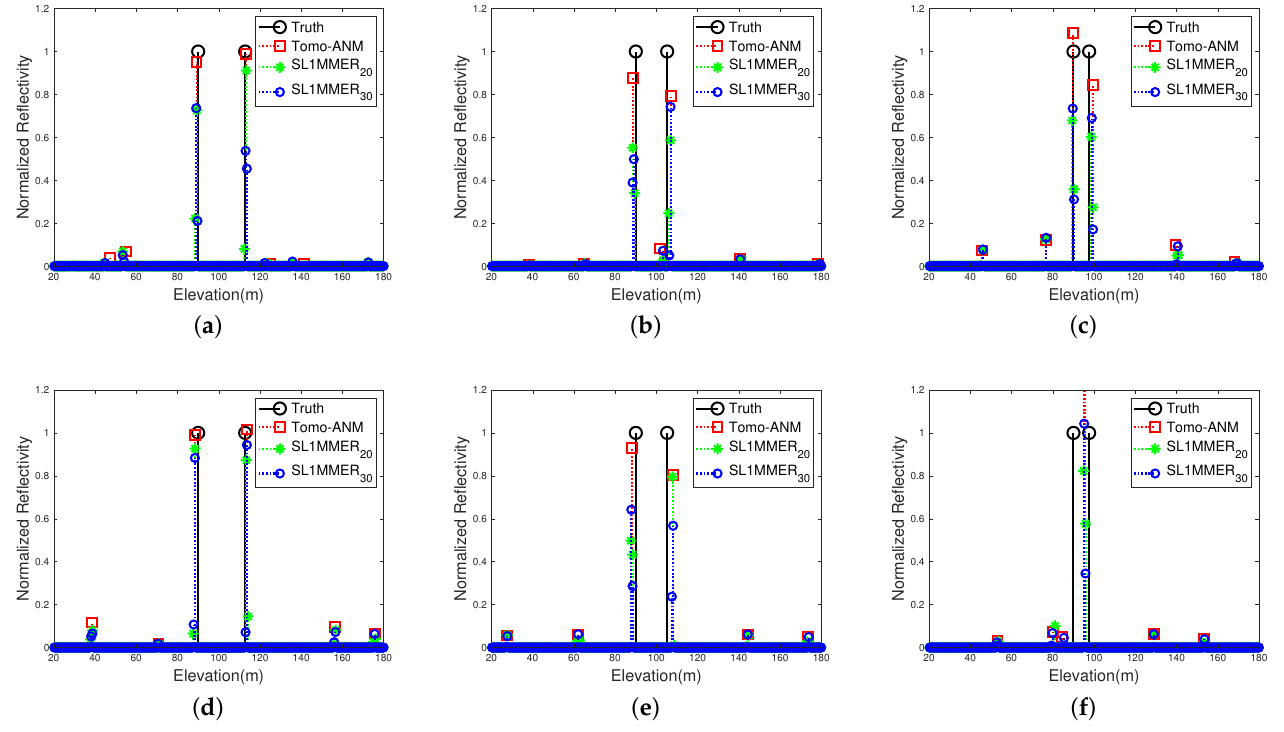
Figure 6. Super-resolution capability comparisons between Tomo-ANM, SL1MMER 20 and SL1MMER 30 under different SNRs and normalized distances. ( a ) SNR = 10 dB, k s = 1.2. ( b ) SNR = 10 dB, k s = 0.8. ( c ) SNR = 10 dB, k s = 0.4. ( d ) SNR = 5 dB, k s = 1.2. ( e ) SNR = 5 dB, k s = 0.8. ( f ) SNR = 5 dB, k s =